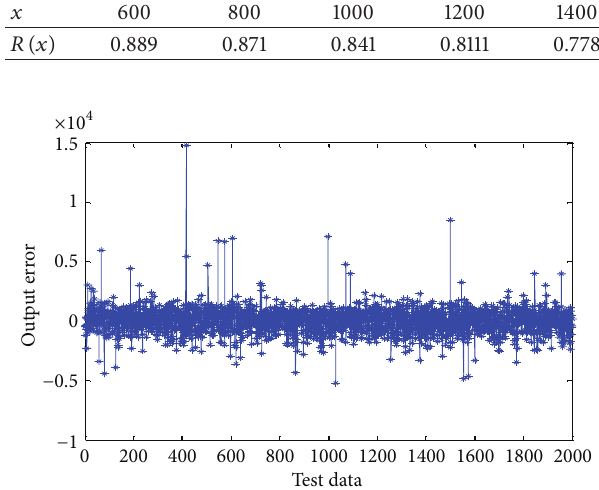
Figure 9: Output error of the proposed